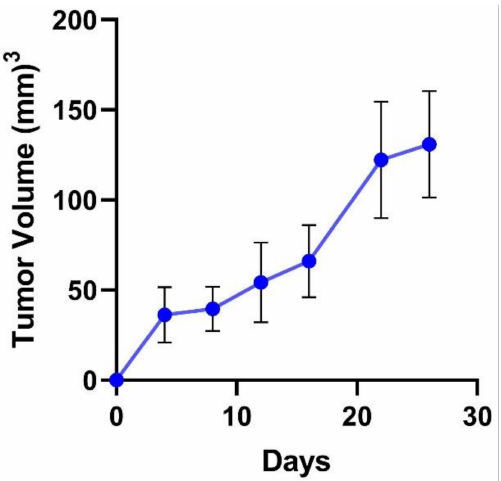
Figure 3. The growth curve of established tumors ( n = 21, mean ± SD) using direct subcutaneous injection of MDA-MB-231 cells (2 million in media and Matrigel, 100 µ L, 1:1) into the right flank of female NOD-SCID mice